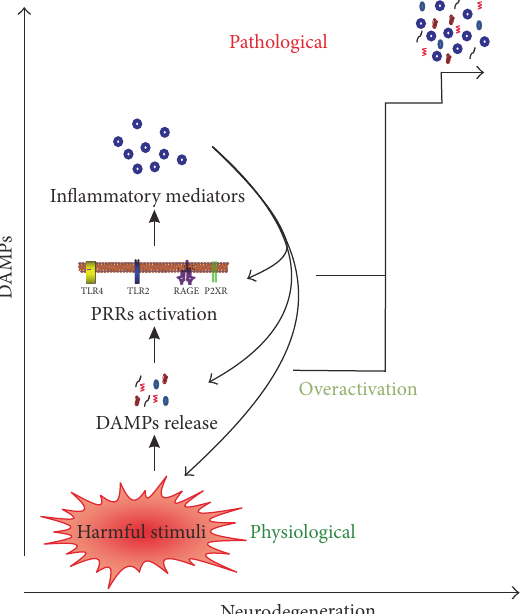
Figure 3: Propagation of “damage signals.” Harmful stimuli in the brain (e.g., brain injury and excessive neurodegeneration) generate endogenous DAMPs that induce the release of inflammatory medi- ators by activating PRRs. In turn, these molecules upregulate their own expression, directly activate the release of DAMPs, and trigger further tissue damage leading to increasing DAMPs level. Hence, a sustained aggressivecycle may result inchronic neuroinflammation. However, a controlled release of DAMPs has beneficial roles in immunity and tissue repair process.